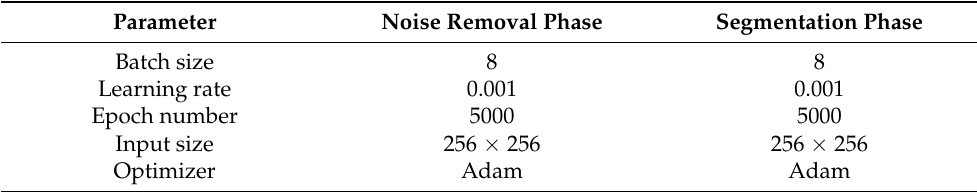
Table 1. Parameters used in training phases.